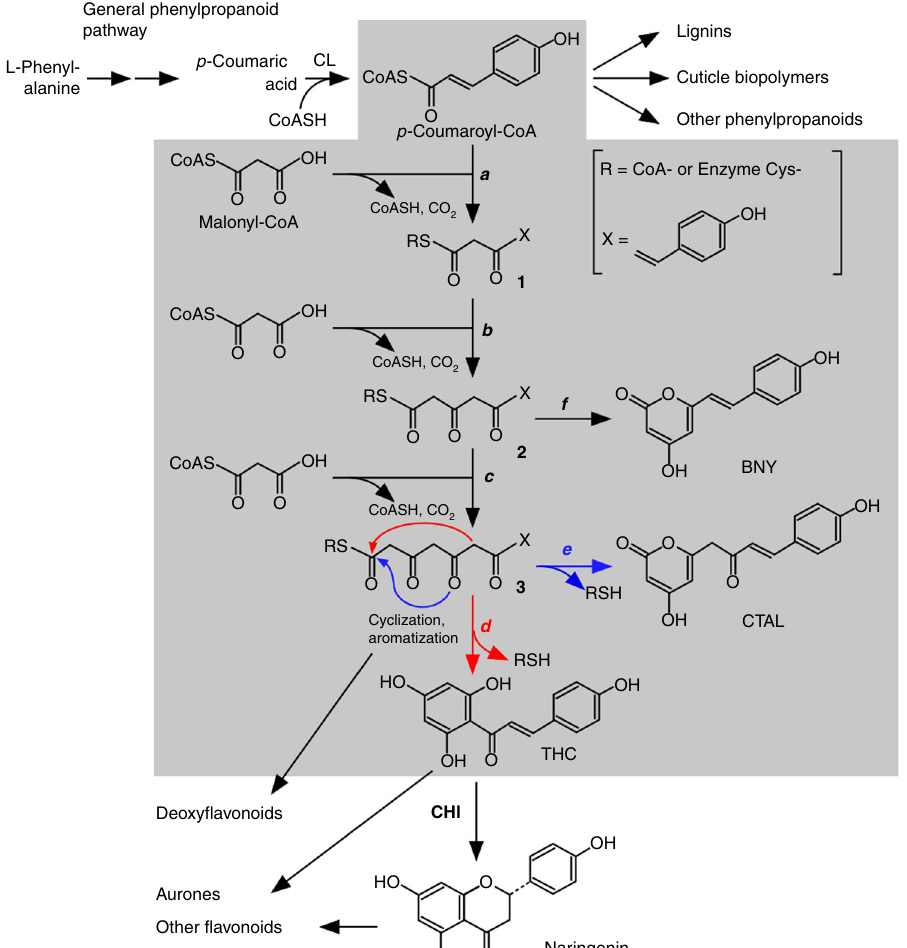
Fig. 1 Chalcone synthase (CHS)-catalyzed formation of THC and other polyketides. The CHS-catalyzed process (steps a through f ) is presented in a gray background. One of the CHS substrates, p -coumaroyl-CoA, is derived from L-phenylalanine via the general phenylpropanoid pathway and serves as a precursor of lignin, cuticle biopolymers, and other phenylpropanoids in plants. A diffusible intermediate of the CHS-catalyzed reaction may serve as a substrate of chalcone reductase in deoxy fl avonoid biosynthesis 10 . Additionally, THC serves as a precursor of aurones, whereas naringenin serves as a precursor of other fl avonoids 6,11 . CL, 4-coumaric acid:CoA